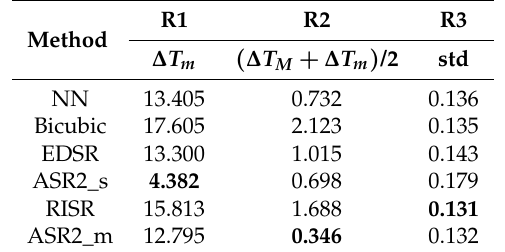
Table 3. Results of the tests on the I1 image with different methods. ∆ T M and ∆ T m are defined in (12) and are expressed in Celsius degrees; std is the standard deviation. For each ROI, highlighted in bold font are the values that best reproduce the regions specific features. Reference values for the ground